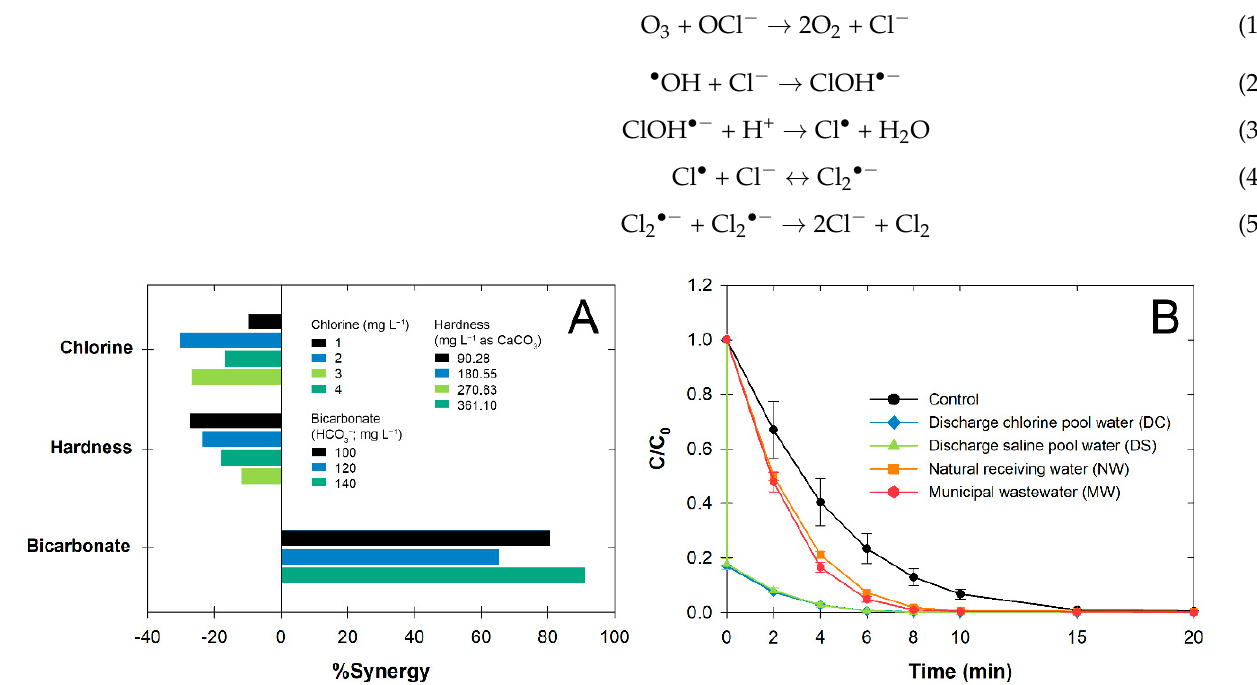
Figure 6. ( A ) Comparison of observed rate constant ( k obs ) with different influential effects, ( B ) Temporal changes in BP at different water matrices (catalyst: 0.2 g L − 1 , [BP o ]: 10 µM, pH 7, 25 °C). Error bars indicate ± standard deviation.